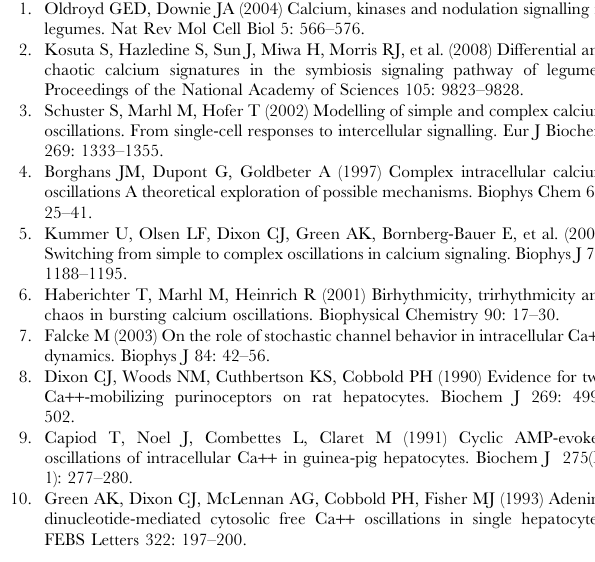
Figure S9 An original experimental time series (black), after detrending with a mov- ing average to produce Nod11 (blue) and Nod12 (cyan) and after detrending using EMD to produce Nod11 (red) and Nod12 (purple). Y axis is a fluorescence ratio between Ca 2 + sensitive and Ca 2 + insensitive dyes. The detrended time series were truncated to obtain long, stationary segments. Figure S10 Examples of an experimental time series after moving average detrending (red), an AR model fitted to the experimental data (green) and a surrogate time series (blue). Y axis is a fluorescence ratio between Ca 2 + sensitive and Ca 2 + insensitive dyes. Figure S11 Example of a time series truncated for stationarity. a) The original time series is given in red and the time series, after trunctation, is given in blue. b) The cluster of p -values (y axis) that indicate nonstationarity when the entire series is analysed. c) The results of the staionarity test after truncation. The red line marks the p -value 0.05 which is used as a cutoff for clusters of non-stationary p -values. When a a p -value is calculated that is , 0.05 it is marked with a red dot. Figure S12 Examples of indirect Lyapunov exponents calculat- ed for an experimental time series and an AR model used as a negative control. The ‘L’ values indicate the delay time or lag that was used for particular models and the points are only plotted for the best fitting model for each dimension and lag. Found at: doi:10.1371/journal.pone.0006637.s014 (0.22 MB